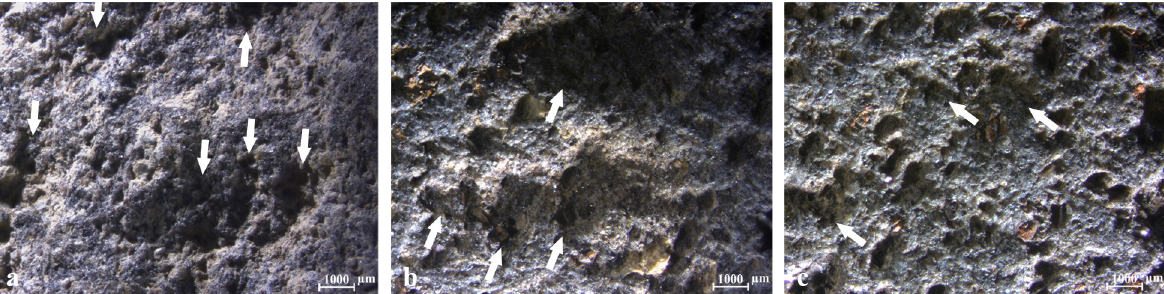
Fig 8. Wear typical to the vessels’ exterior. (a) Exterior wall of the Early Bronze Age I vessel fragment from Tel Bet Yerah showing pecking marked with arrows (10x); (b) Exterior wall of the Late Chalcolithic vessel fragment from Yehud showing abraded pecking marks marked with arrows (10x); (c) Exterior base of the same bowl from Yehud exhibiting extremely abraded pecking marks marked with arrows (10x).